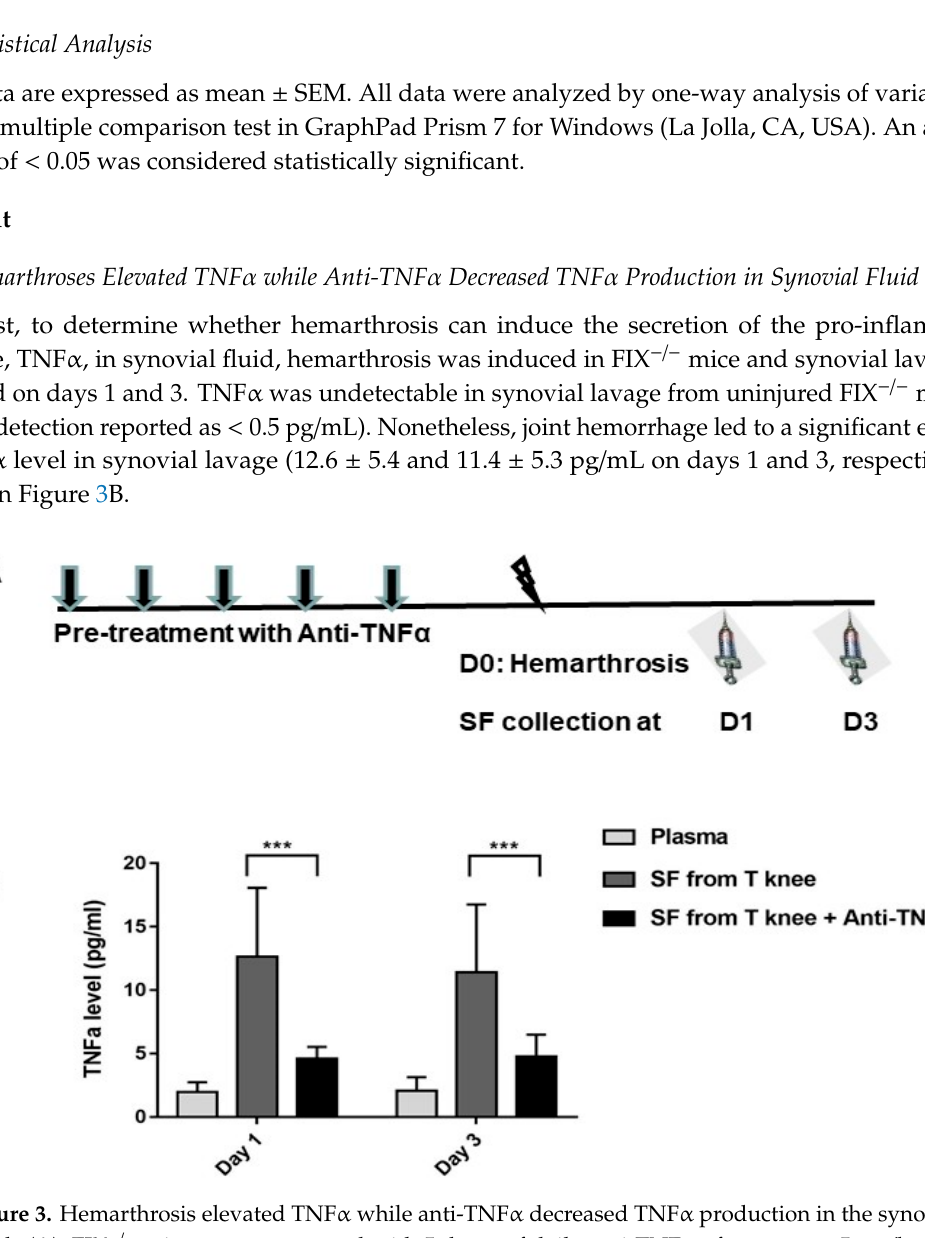
Figure 3. Hemarthrosis elevated TNF α while anti-TNF α decreased TNF α production in the synovial fluid. ( A ): FIX − / − mice were pre-treated with 5 doses of daily anti-TNF α of etanercept 5 mg/kg s.c.; normal saline was administered to the control. On day 0, pretreated mice were subjected to hemarthrosis induction (arrow head). Synovial lavage from injured knee (“SF from T knee,” “SF from T knee + TNFi”) and contralateral knee were collected on days 1 and 3. ( B ): TNF α levels were detected. Results are presented as mean ± standard deviation. Synovial lavage from contralateral knee was undetectable on days 1 and 3. N = 7–8 for each time point. *** p < 0.001. Each value represents the mean ± standard deviation.